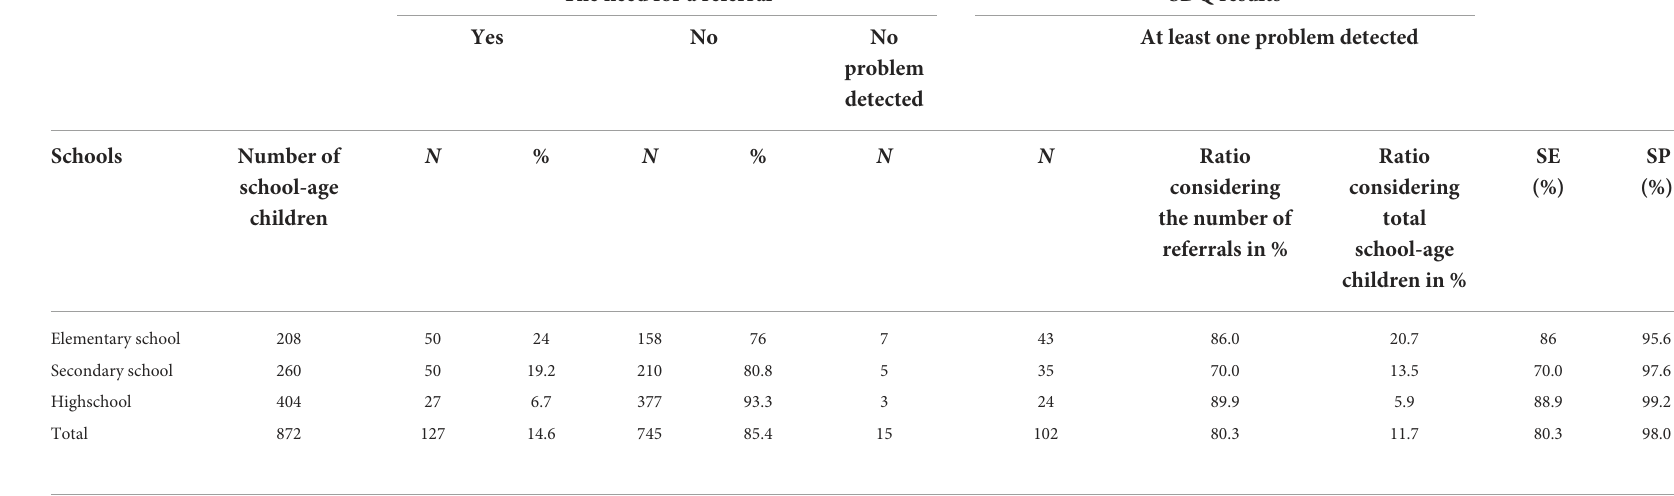
TABLE 2 Frequency distribution of schoolchildren referred by school teachers to school counselor and their SDQ results.